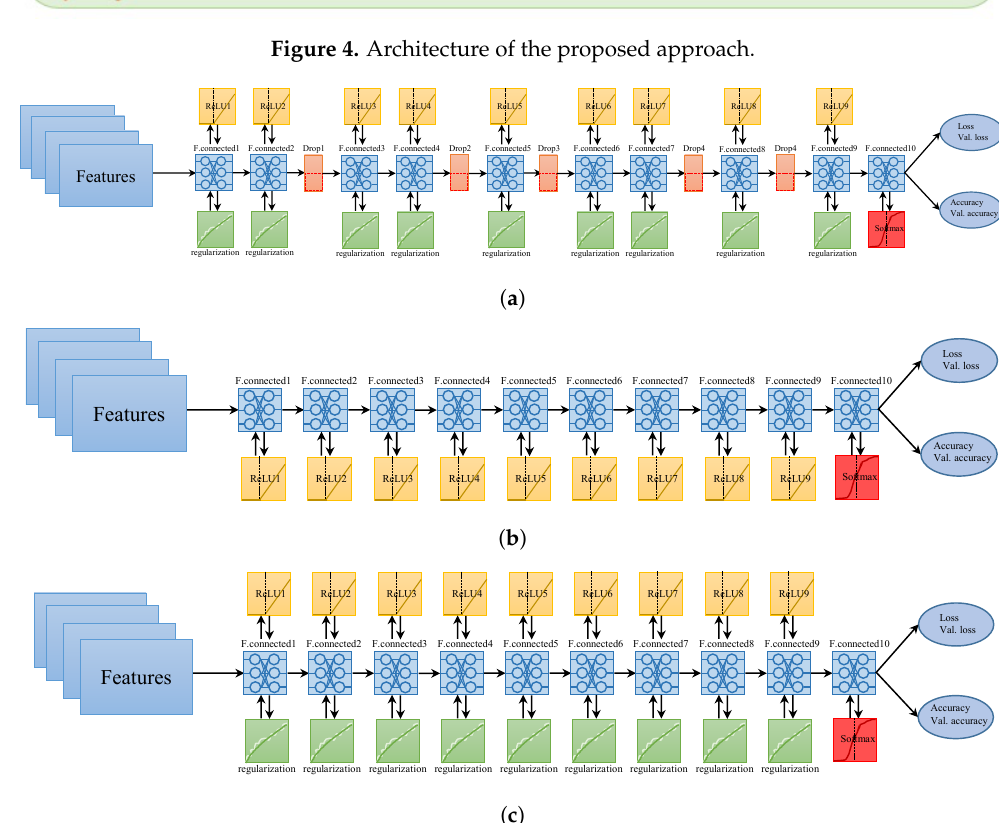
Figure 5. Structure of neural networks (NN), ( a ) NN 1 ; ( b ) NN 2 ; ( c ) NN 3